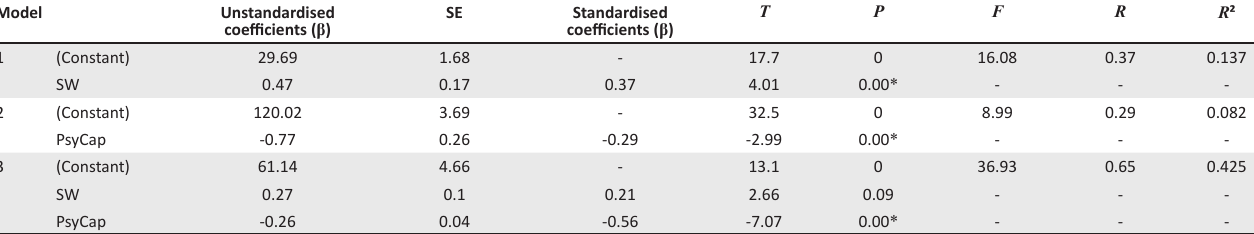
PsyCap, Psychological capital; SW, Subjective well-being; DE, Disengagement; EX, Exhaustion; GS, General satisfaction. * , p ≤ 0.05; ** , p ≤ 0.01; † , r ≥ 0.30 – Practically significant relationship (Medium effect); †† , r ≥ 0.50 – Practically significant relationship (Large effect). TABLE 5: Coefficients showing the relative contribution of subjective wellbeing and PsyCap in predicting burnout.